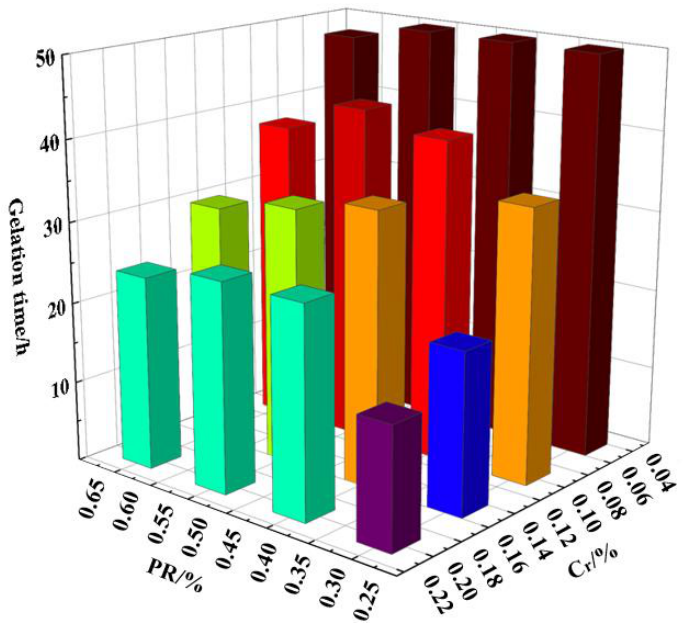
Figure 6. Histogram of gelation time (h) of 0.30% HPAM + PR and Cr 3+ cross-linker (The color represents gelation time of gel).